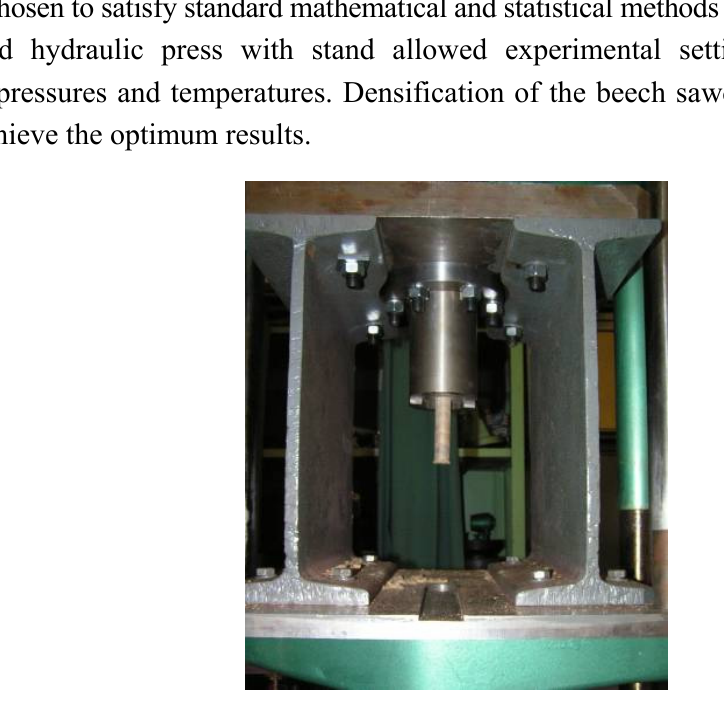
Figure 4. Experimental pressing